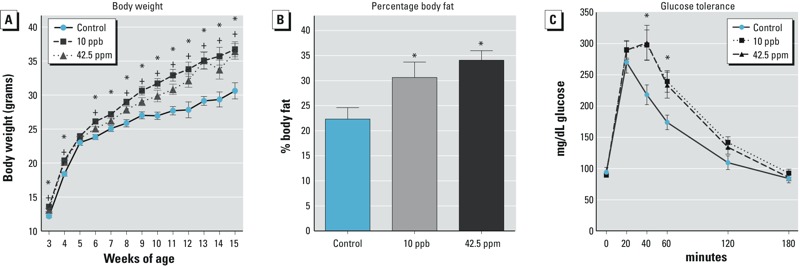
Effects of in utero arsenic exposure on (A) body weight from 3 to 15 weeks of age. *Indicates significant difference (p < 0.05) between the control and the 10-ppb group and + indicates significant difference (p < 0.05) between the control and the 42.5-ppm group. (B) Percentage body fat. *Indicates significant difference (p < 0.05) compared with the control. (C) Glucose tolerance analysis. The y-axis represents serum glucose levels (mean ± SE; *indicates p < 0.05 compared with the control).